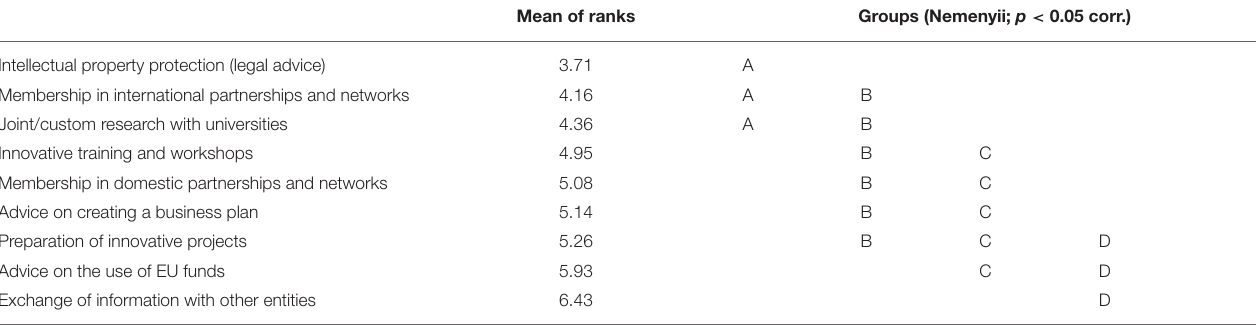
TABLE 4 | Importance of utilization of external financial sources to boost innovations. Mean of ranks Groups (Nemenyii; p < 0.05